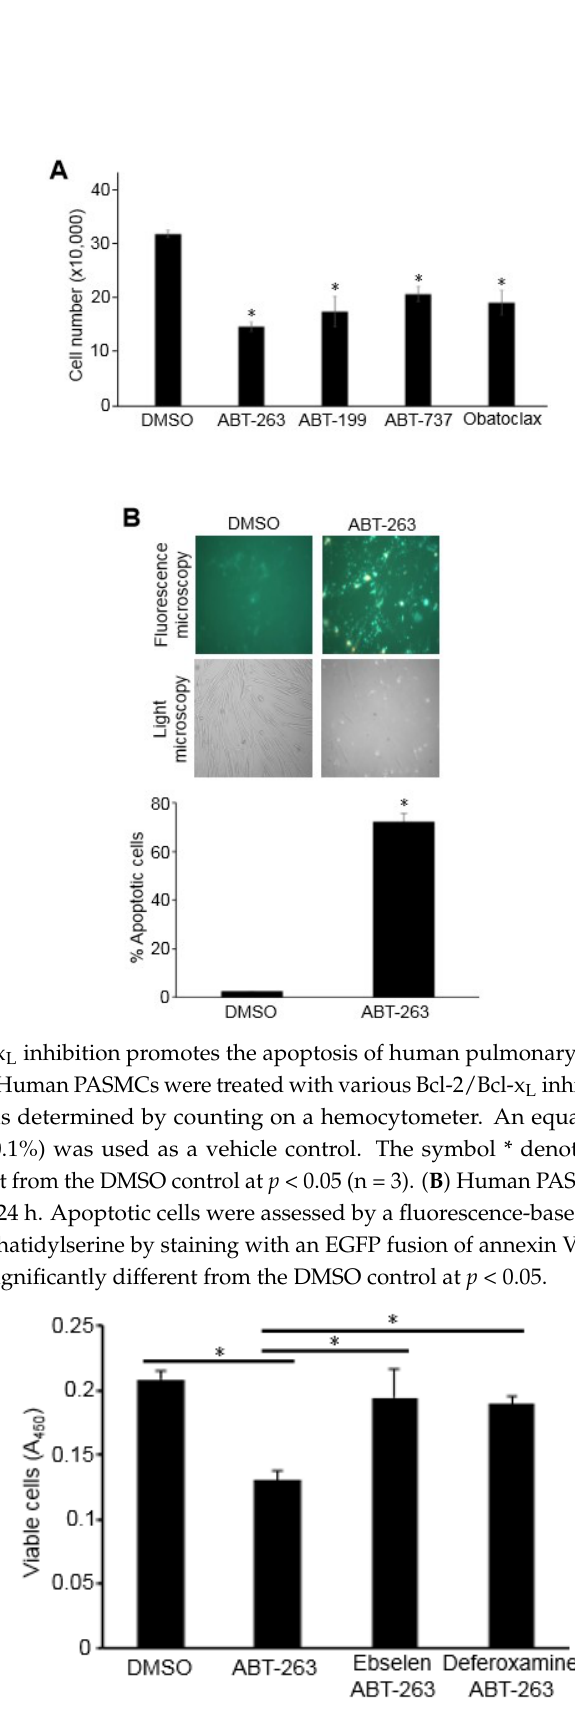
Figure 2. Effects of antioxidants on ABT-263-induced cell death. Human PASMCs were treated with ABT-263 (1 µM) with or without ebselen (20 µM) or deferoxamine (50 µM) for 24 h. The number of viable cells was monitored using the Cell Counting Kit-8 at absorbance 450 nm (A 450 ). * denotes that the values were significantly different from each other at p < 0.05 (n = 8).